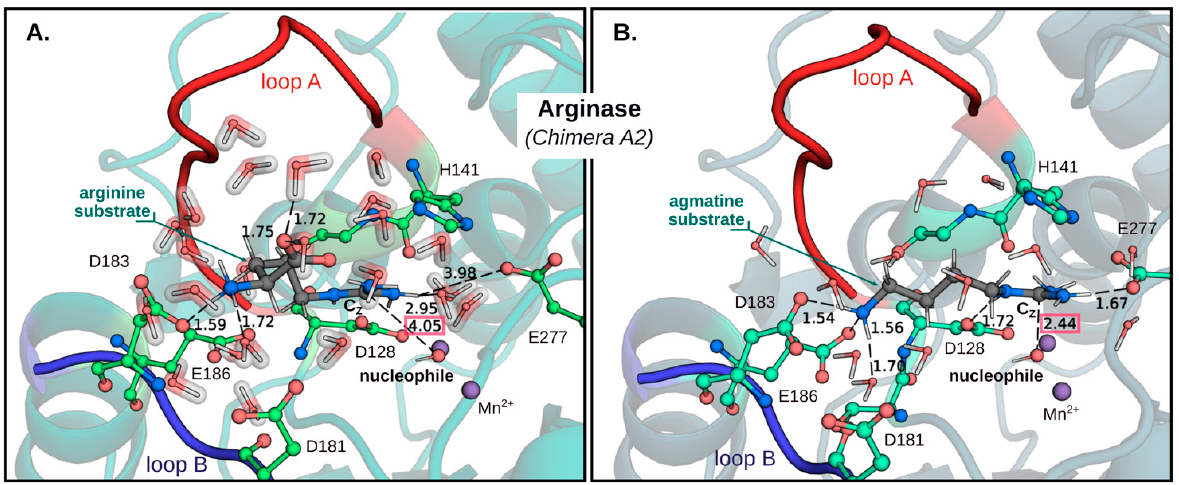
Figure 5. Optimized structure of the Michaelis–Menten complex reactant of Chimera A2 arginase at the B3LYP/6-31+G*:CHARMM36 level. ( A ) Chimera model with arginine substrate. The waters that interact directly with the substrate are highlighted with a shadow representation. ( B ) Chimera with agmatine substrate. The interatomic distances are in Å.